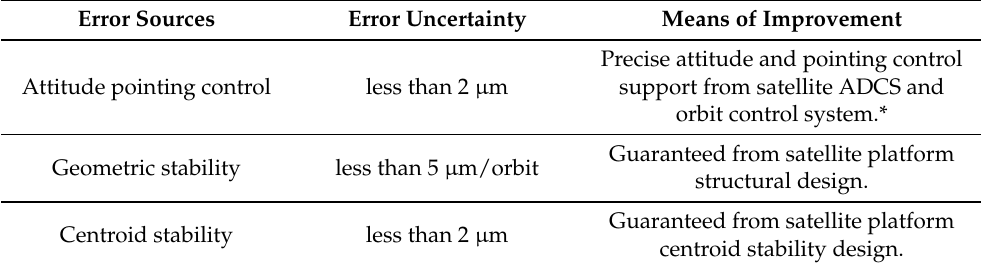
Table 2. Error analysis of distance transformation from antenna phase centers to